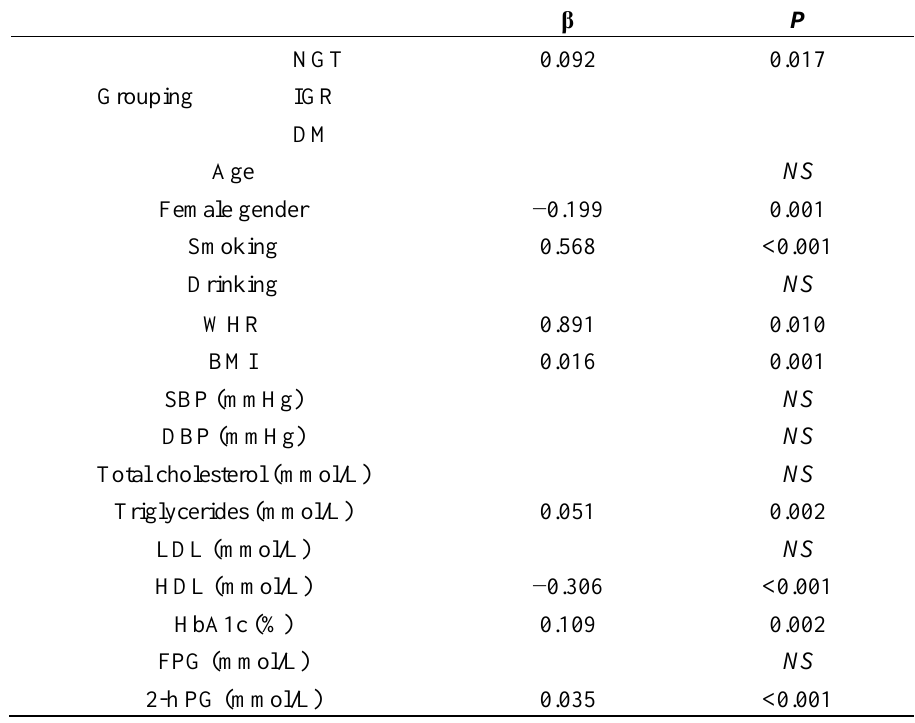
Table 3. Relevant Variables associated with WBC Count in NGT, IGR and newly diagnosed